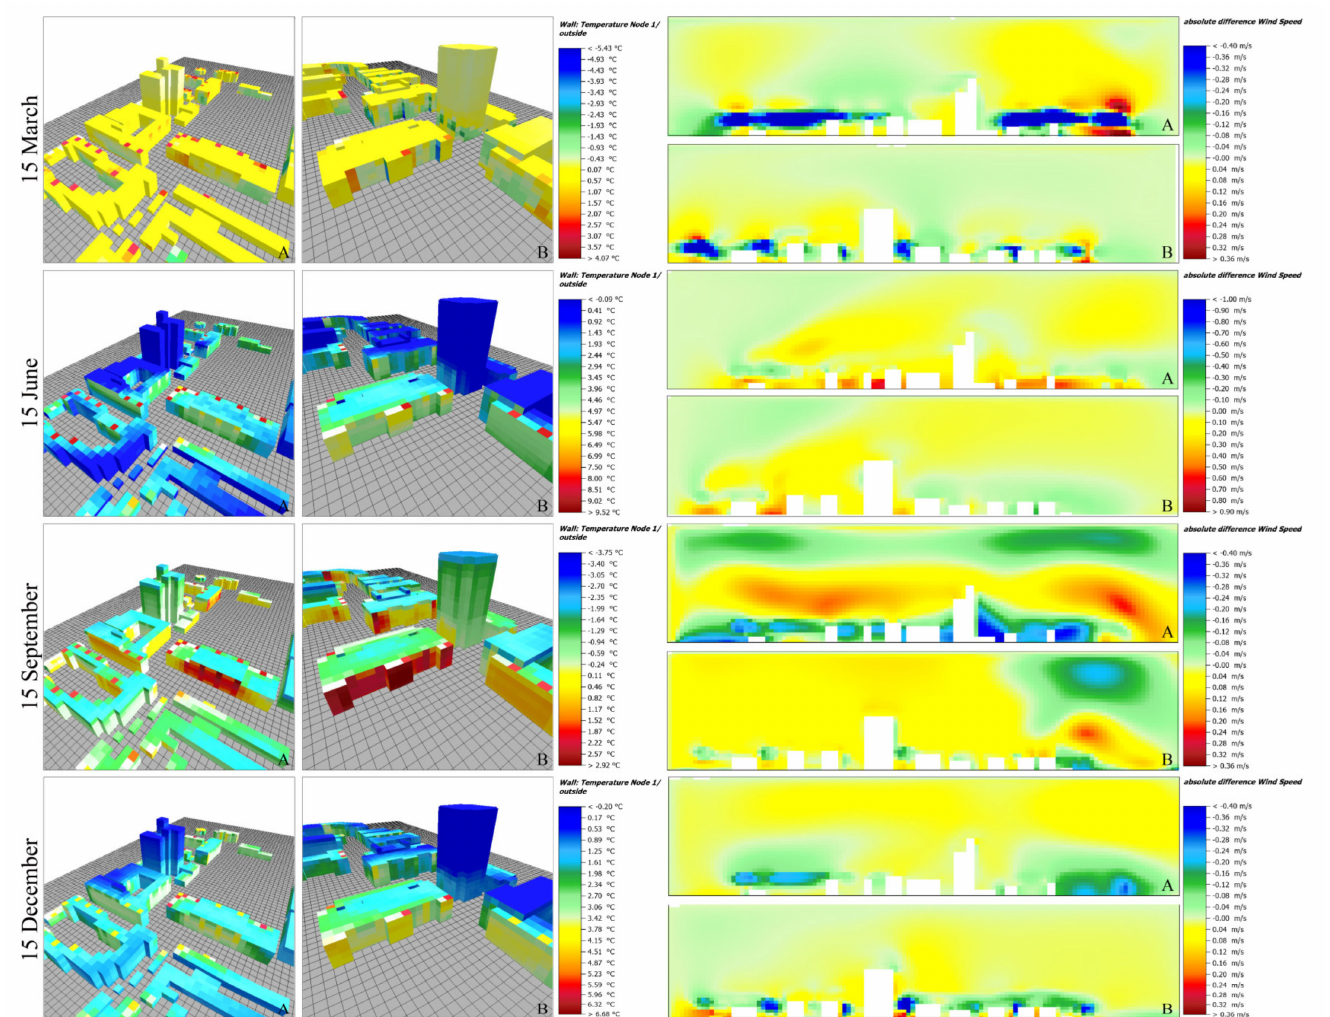
Figure 12. Façade temperature and surrounding airflow changes of two high-rise buildings at 16:00 p.m. on four